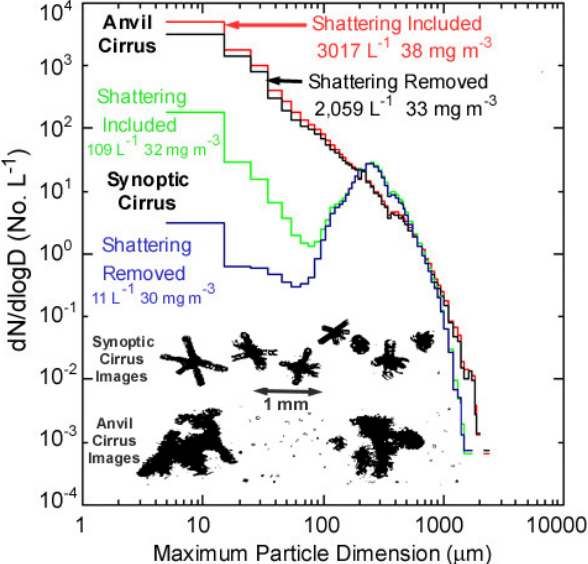
Figure 13. As in Fig. 12 except the size distributions are shown as a function of particle mass. Fig. 13. As in Fig. 12 except the size distributions are shown as a Two 2D-S probes, one with and one without modified probe tips, were flown side-by- function of particle side on the SPEC Learjet in the SPARTICUS field project. The modified probe tips were designed with the assistance of Dr. Korolev, and are based on theory and knowledge learned from the icing tunnel videography. Analysis of data collected in large aggregates shows that the modified 2D-S probe tips substantially reduce the number of small (shattered) particles; however, post-processing with the arrival time algorithm is more effective, whether applied to the probe with modified or unmodified tips. This is contrary to the results for the 2D-C and CIP presented by Korolev et al. (2010b).